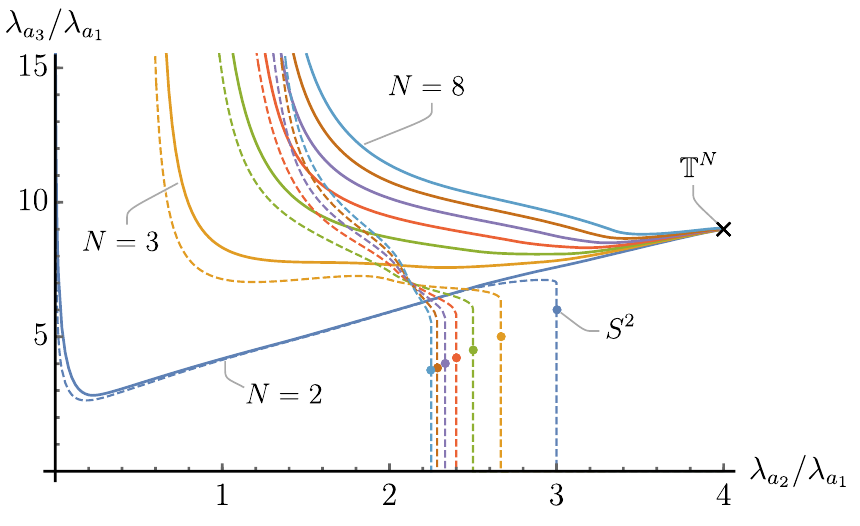
JHEP10(2020)069